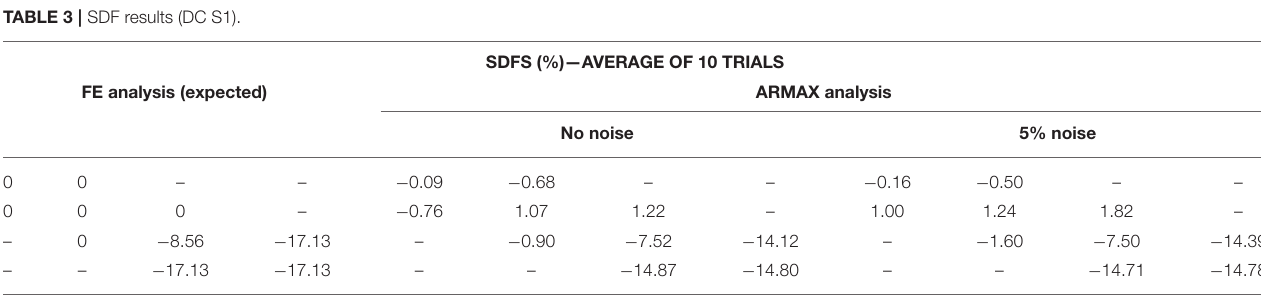
TABLE 3 | SDF results (DC S1).